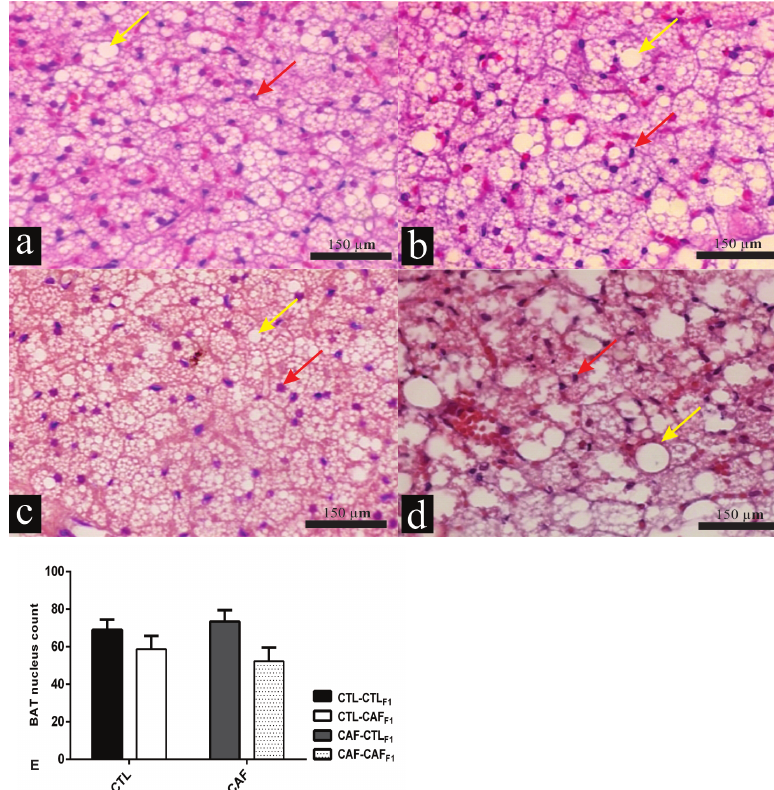
Figure 2 - Effect of exposure to CAF diet pre and post weaning, alone or in combination, on histological aspects of BAT from male adult F1 offspring at 100 d of age. Representative histology of BAT with H&E staining (200X magnification); a-d ; Scale bars: 150 μm. The profile of lipid droplets in the cytosol of adipocyte of BAT was qualitatively evaluated using next criterions; small lipid droplets (+), mild lipid droplets (++) and big lipid droplets (+++). Quantitative analysis was performed by nuclei counts ( e ). Data are mean ± standard error mean (SEM). Nuclei are indicated by red arrows and lipid droplets are indicated by yellow arrows. The number of animals analyzed was 5-7 rats per group from five different